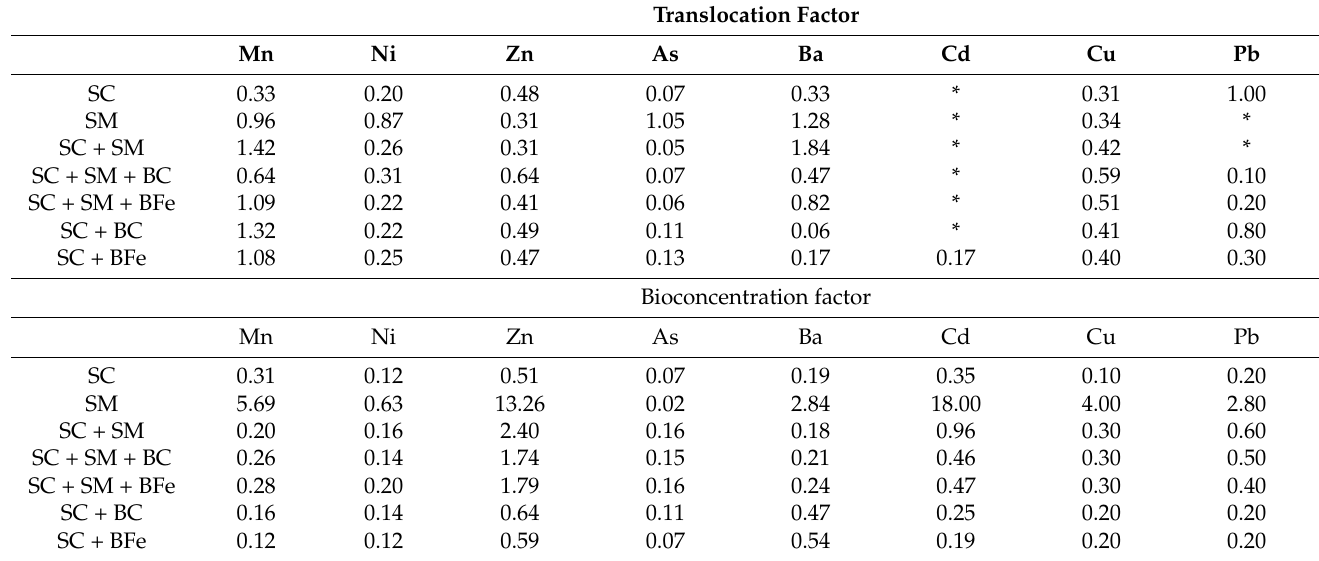
Table 7. Translocation and bioconcentration factors in Ipomoea asarifolia